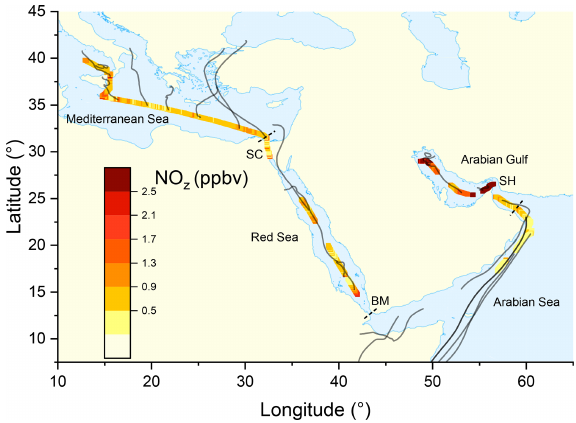
Figure 1. Mixing ratio of NO z from the second leg of the cam- paign, colour-coded along the ship track. Each data point repre- sents an average over 30min. Grey lines represent HYSPLIT 48h back-trajectories starting from the ship location at 100m height. SH = Strait of Hormuz; BM = Strait of Bab al-Mandab; SC = Suez